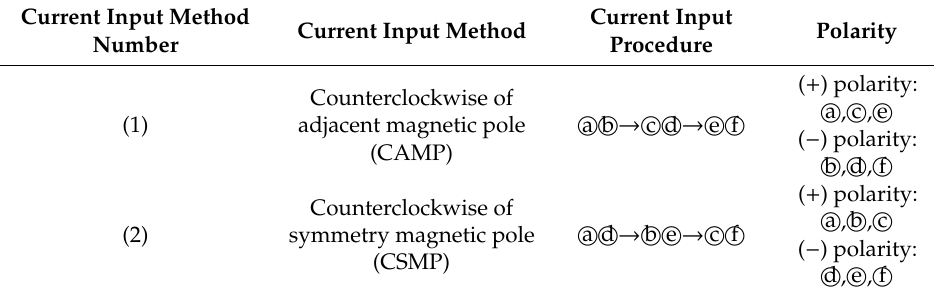
Table 3. Magnetic current input